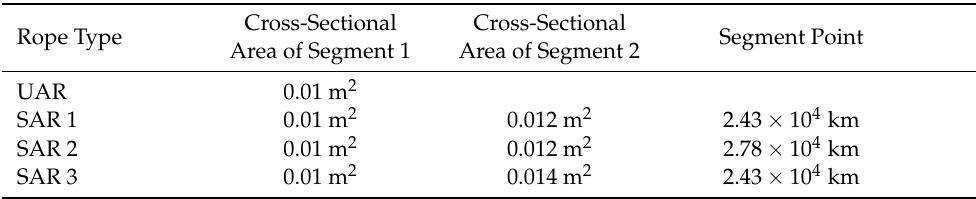
Table 1. Parameters of space elevator systems.